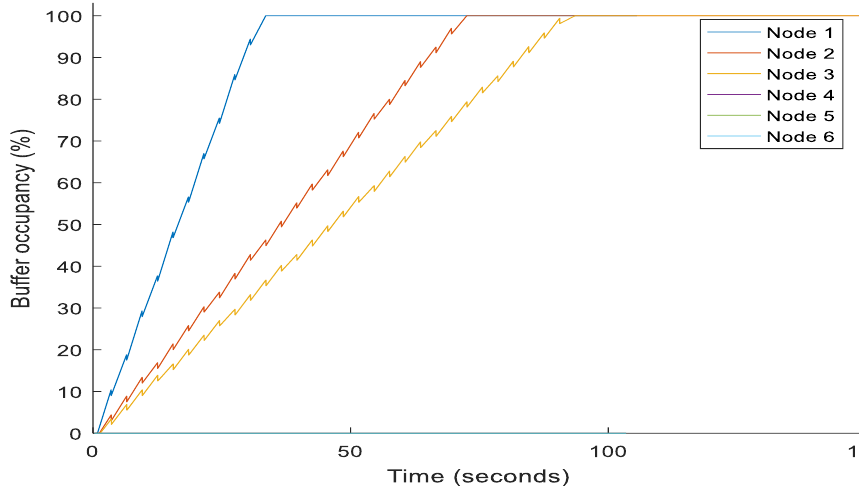
Figure 7. Buffer occupancy with NoDCCP at 0.2 Mbps.